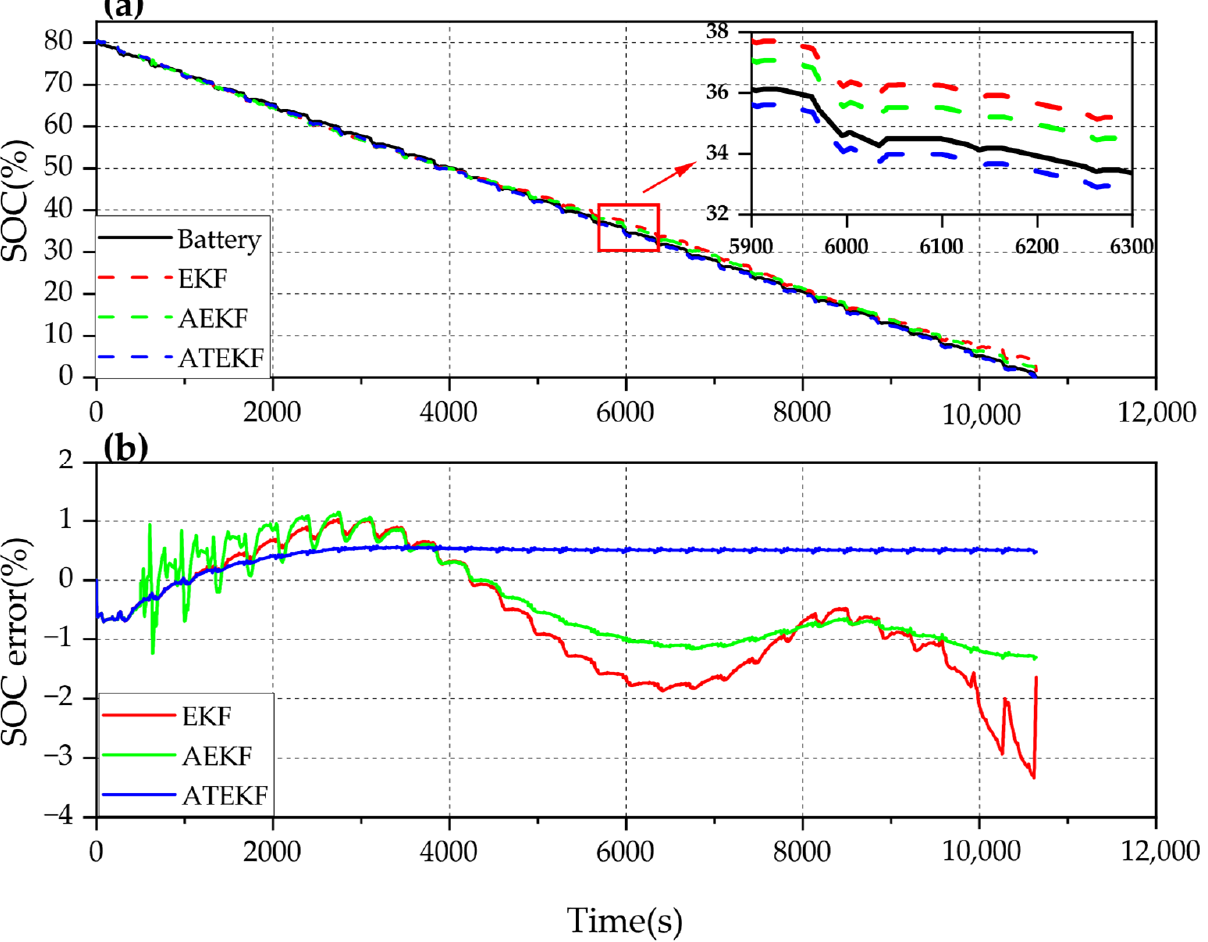
Figure 7. DST under 25 °C: ( a ) actual SOC, prediction of EKF, AEKF, and ATEKF; ( b ) SOC error comparison of EKF, AEKF, and ATEKF.